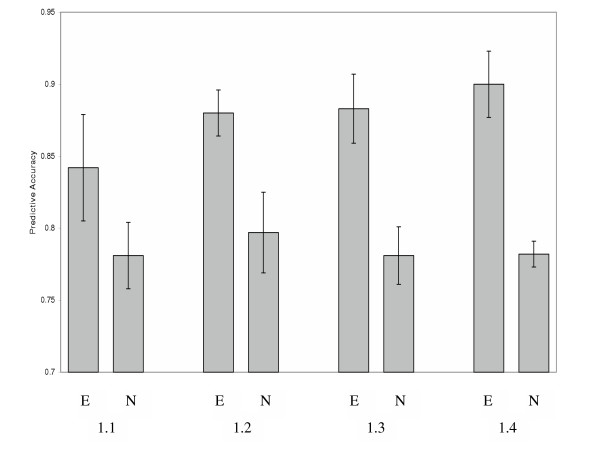
Maximum predictive accuracy of OGA Chromosomes on the generalization set in Experiment 1. Mean ± standard deviations are shown for the five replicates of the experimental (E) and negative control (N) runs for the four data sets (1.1 to 1.4) used.